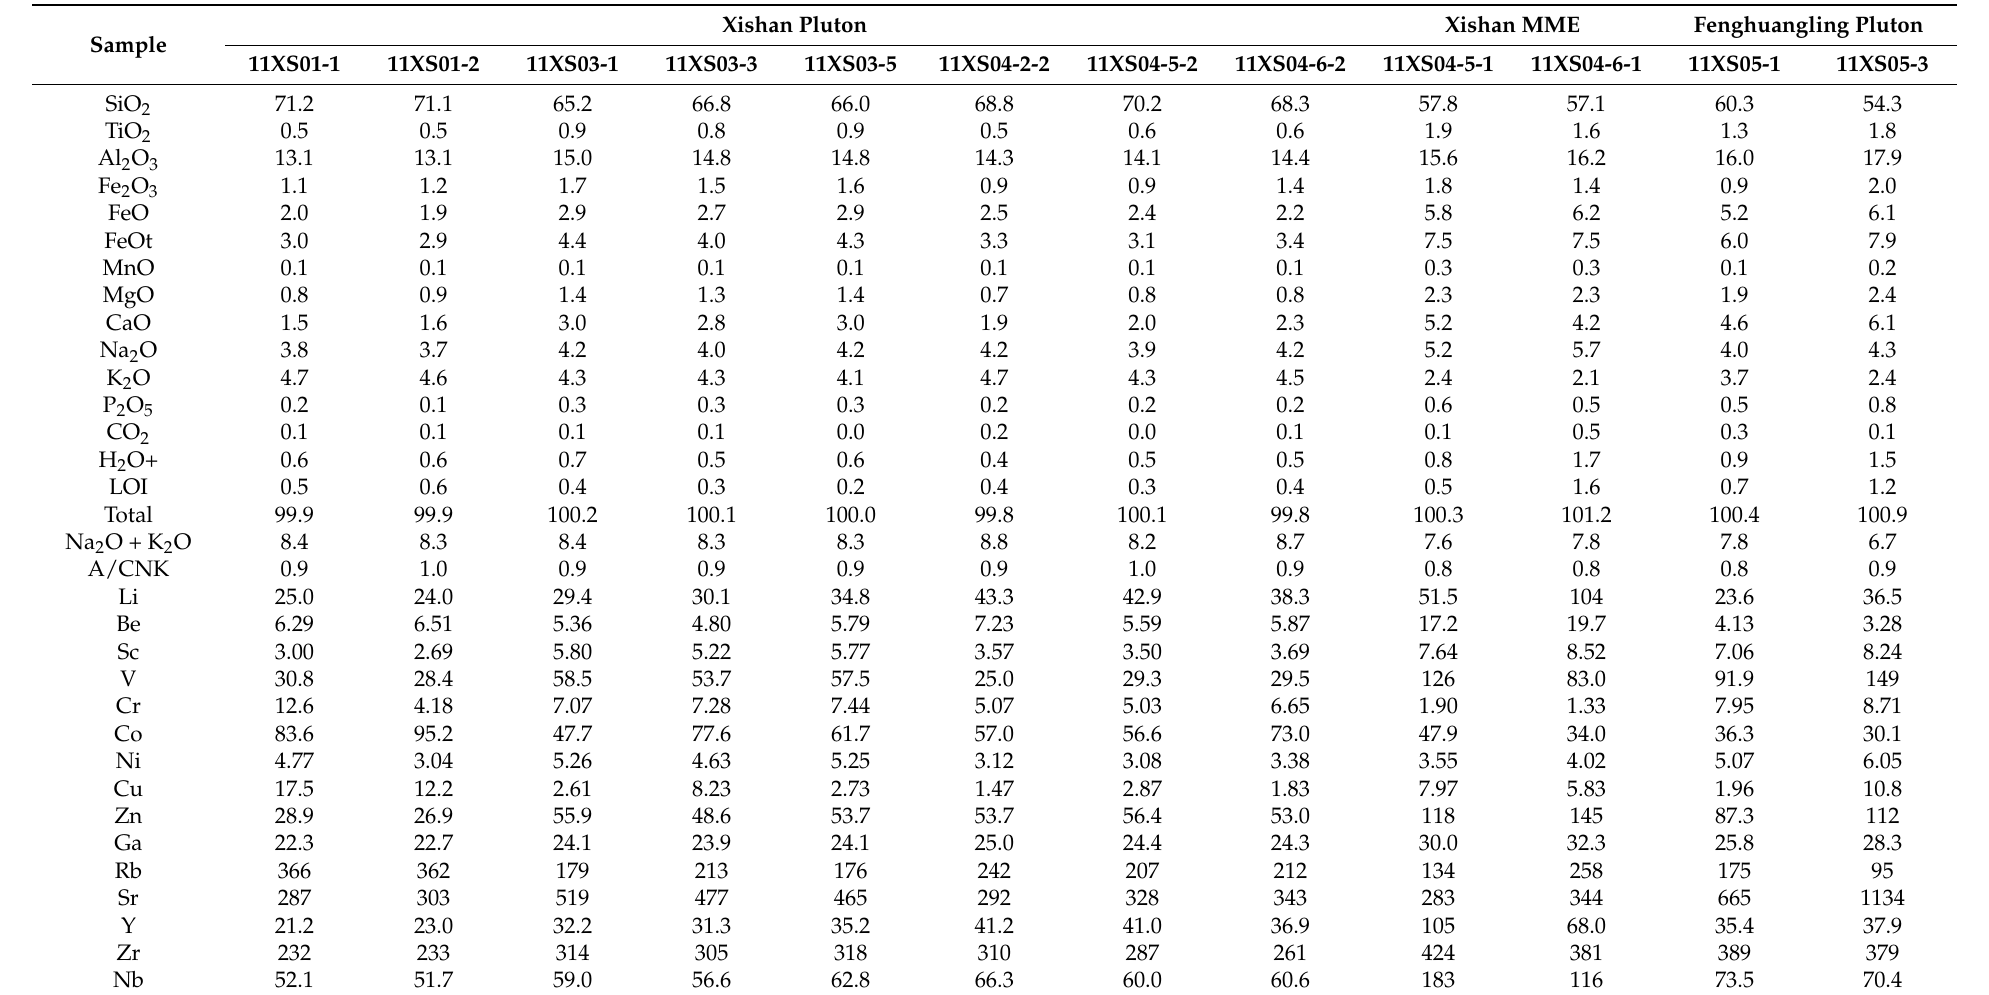
Table 2. Major (wt.%) and trace element (ppm) components of the Guiping